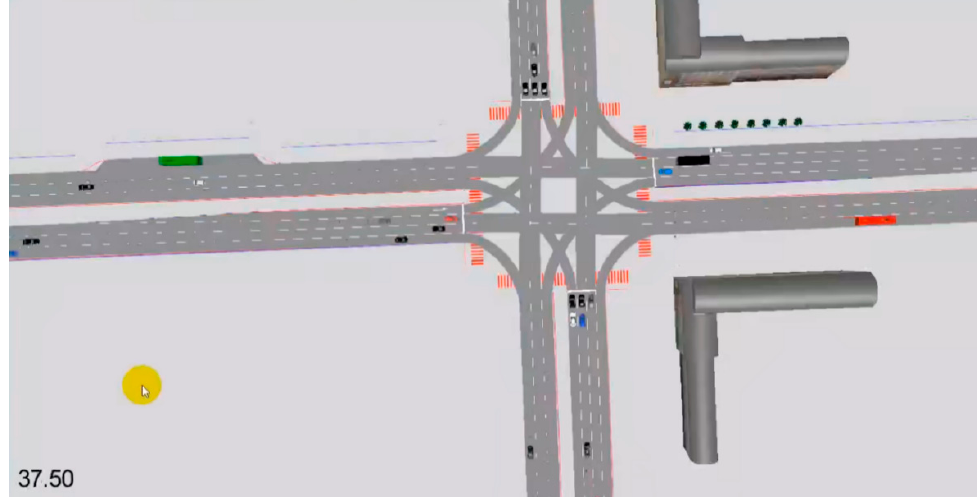
Figure 3. Simulated road network structure.